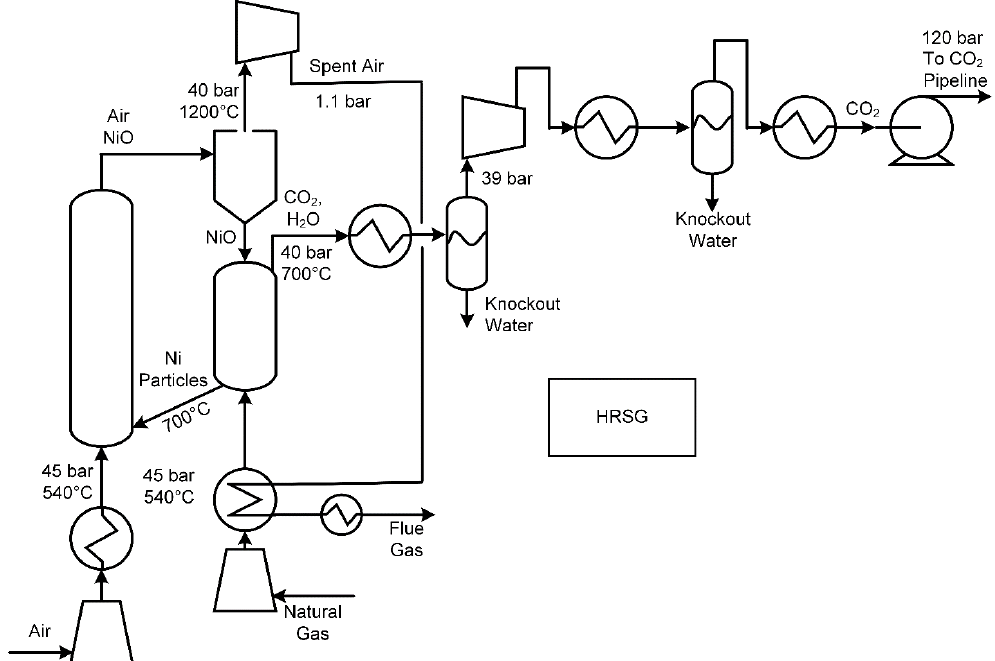
Figure 7. An example chemical looping combustion process using NiO, based on [46].